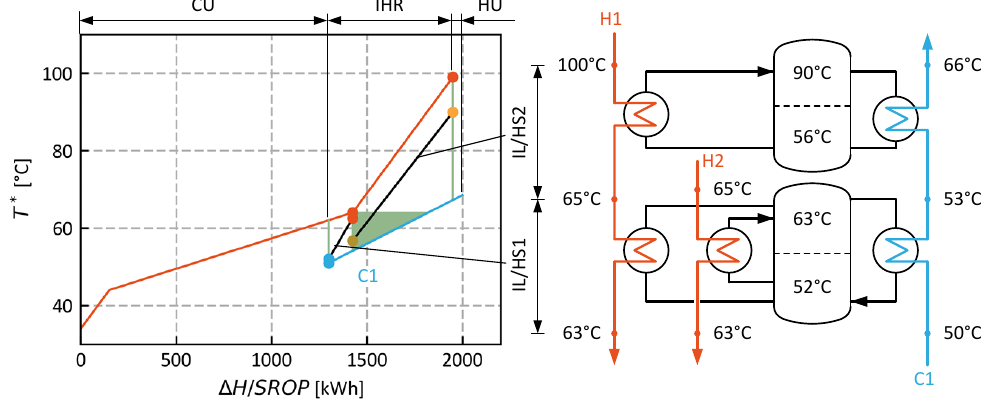
Figure 1. Example of an ISSP (red lines: Source Profile and source streams, blue lines: Sink Profile and sink stream) with three Assignment Zones (AZs) (green lines at beginning and end of IHR and green area in the middle) and the resulting two storage intermediate loops (ILs). The chosen design target is realised with two two-layer stratified heat storage